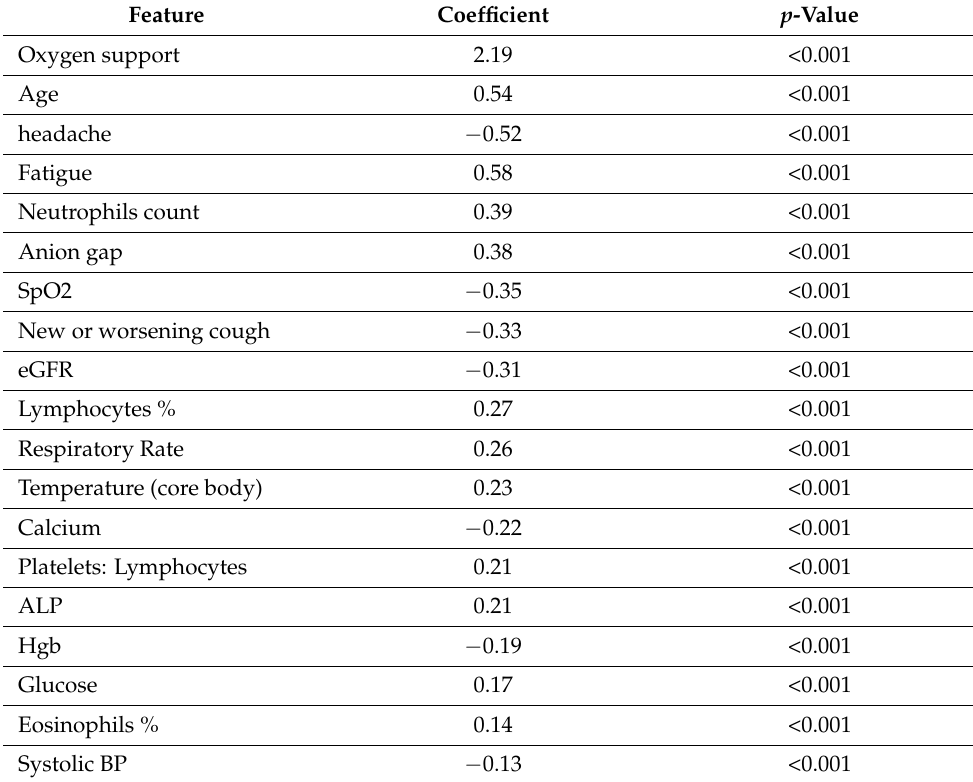
Table A3. Multivariate coefficients and p -values for Comparison 1 (ED admission).